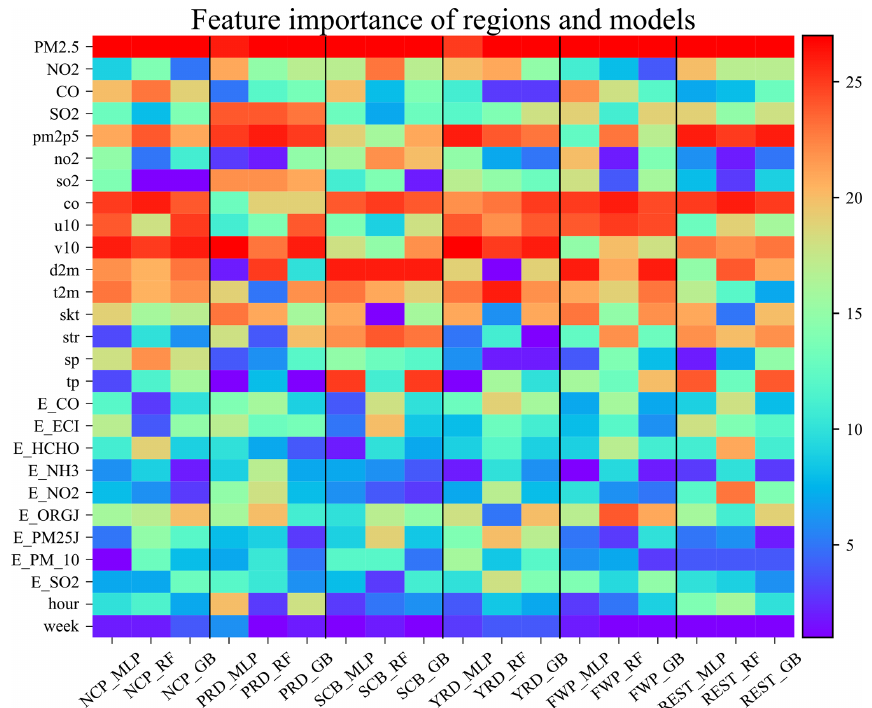
Figure 5. Heatmap of empirical features for six regions with three machine learning models. Each column represents the rearrangement of the sum of 15 monitoring stations and four prediction horizons. Black vertical lines are used to distinguish each region. The warmer the row color, the more critical the corresponding feature.